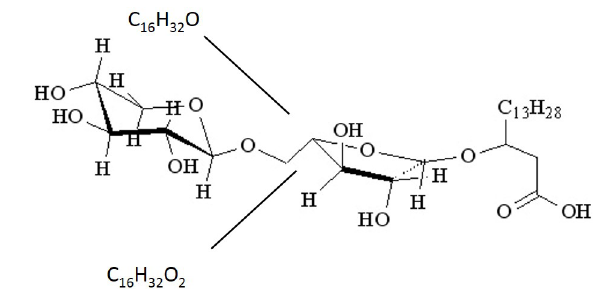
Fig 4 . Structure for the major active compound from S.